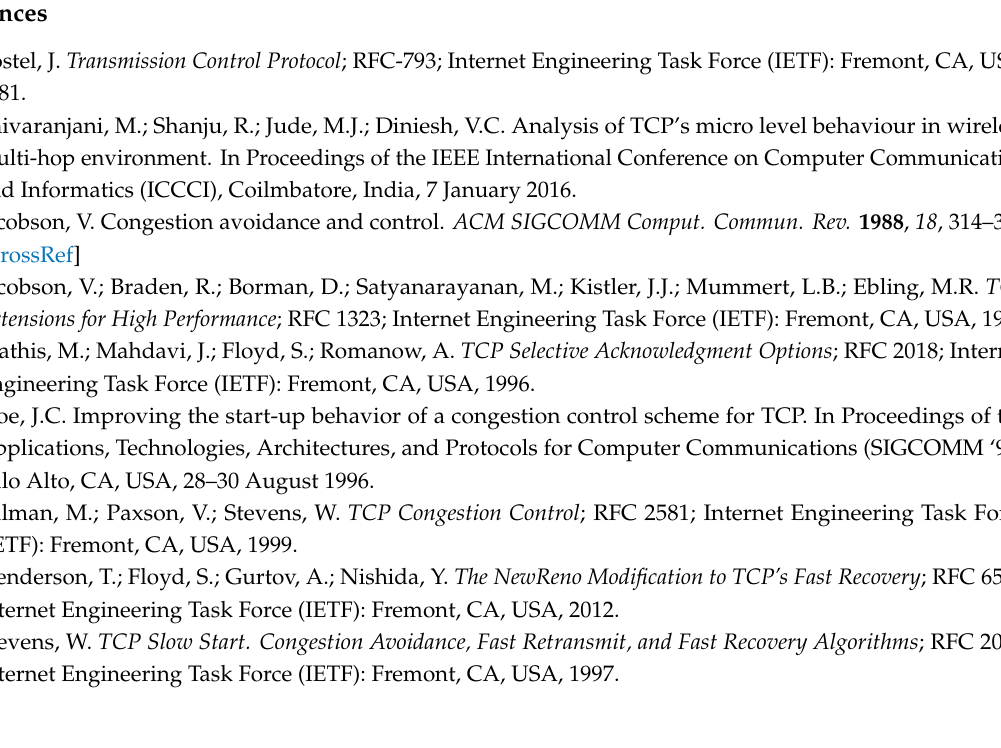
Table S1: Convergence time of the protocols after fast recovery phase. (Test # 1 to 5), Table S2: